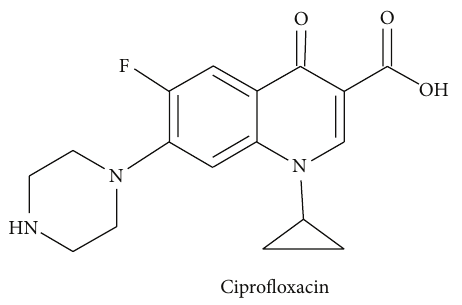
Figure 1: Chemical structure of ciprofloxacin drug.